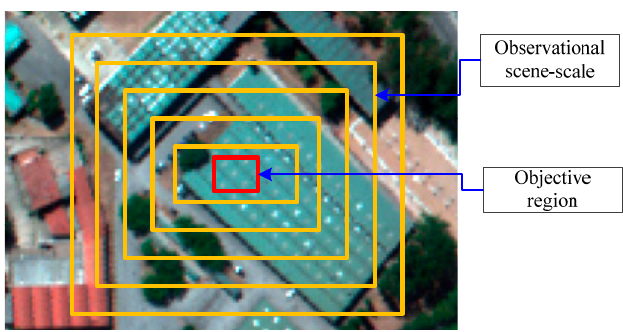
Figure 3. Definition of observational scene scale.